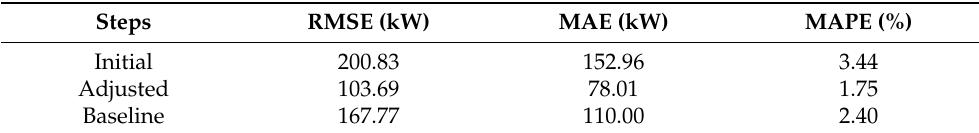
Table 11. Results of the 10-min-ahead forecasts.